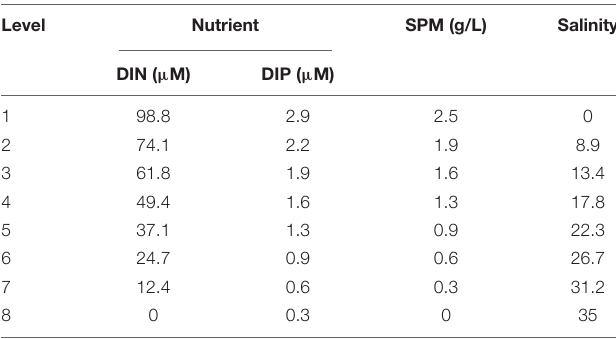
TABLE 1 | Four groups of incubation experiment were designed to contain eight different levels of nutrient, SPM, and/or salinity both individually and in